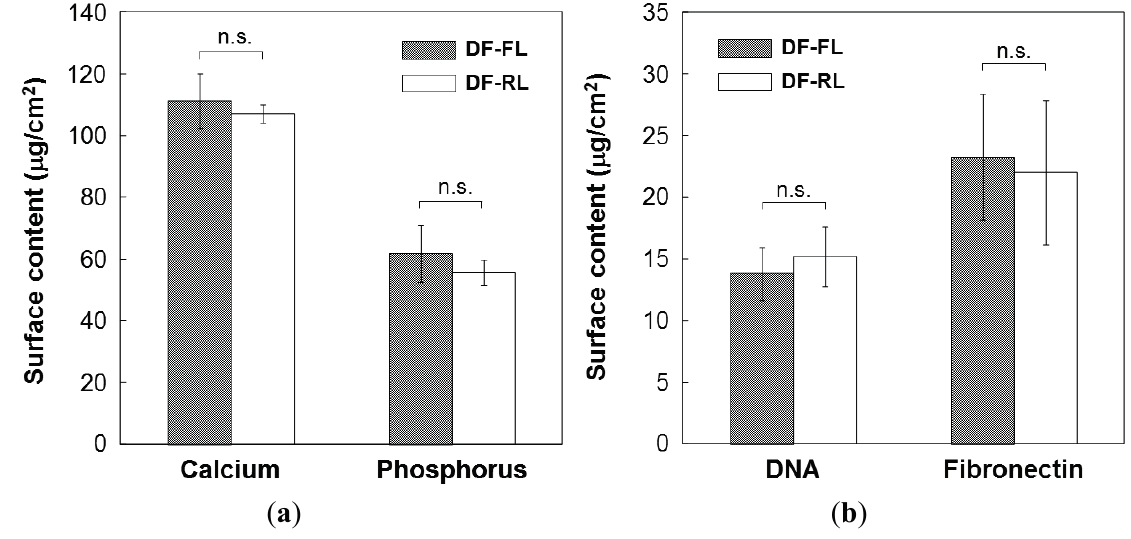
Figure 4. Contents of ( a ) calcium and phosphorus; and ( b ) DNA and fibronectin of the DNA–fibronectin–apatite composite layers (DF-Ap layers) immobilizing firefly